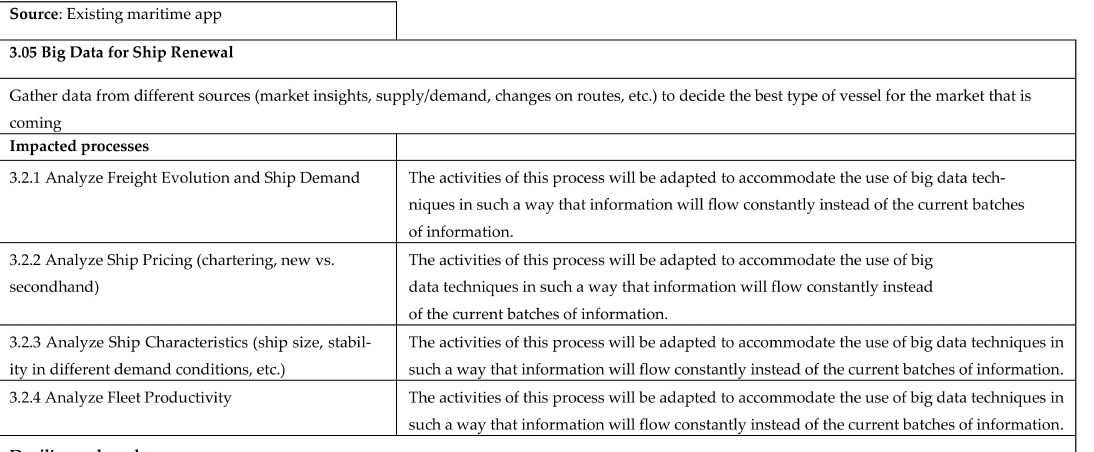
Figure A31. Cont